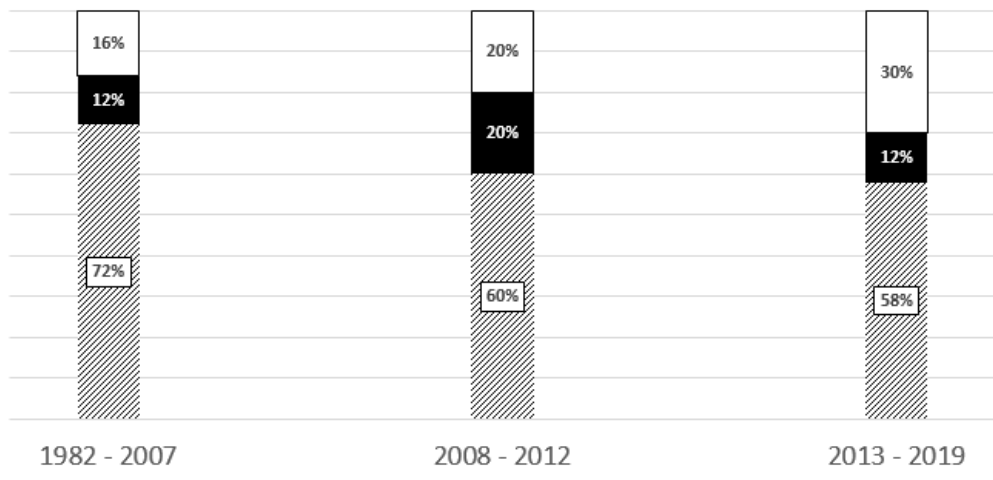
Figure 2. Modes of detection of breast cancer suspected changes according to year of diagnosis.